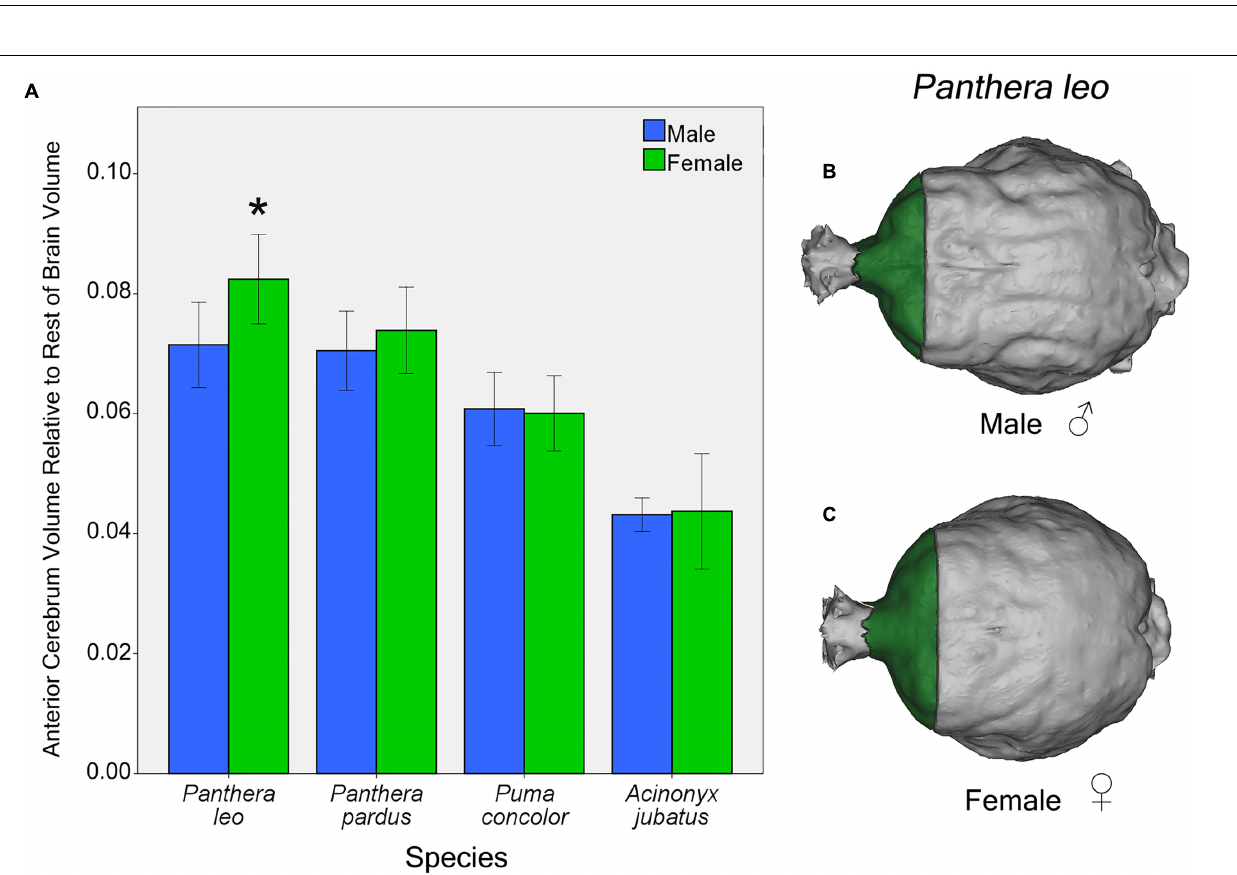
FIGURE 6 | Pairwise comparisons of anterior cerebrum volume, AC (A) and posterior cerebrum volume, PC (B) relative to the rest of endocranial volume in four felid species. Bars indicate 95% CI. Lions and leopards have significantly larger relative ACs than either cougars ( p < 0.001, p = 0.001, respectively) or cheetahs ( p < 0.001, p < 0.001, respectively), and cougars have a significantly larger relative AC than cheetahs ( p < 0.001). Although relative AC volume is greater in lions than in leopards, this difference is not statistically significant ( p = 0.71). Relative PC volume is significantly greater in cheetahs and cougars than in lions ( p < 0.001, p < 0.001, respectively) or leopards ( p < 0.001, p < 0.001, respectively), but does not differ significantly between lions and leopards ( p = 0.74) or between cougars and cheetahs ( p = 0.05).